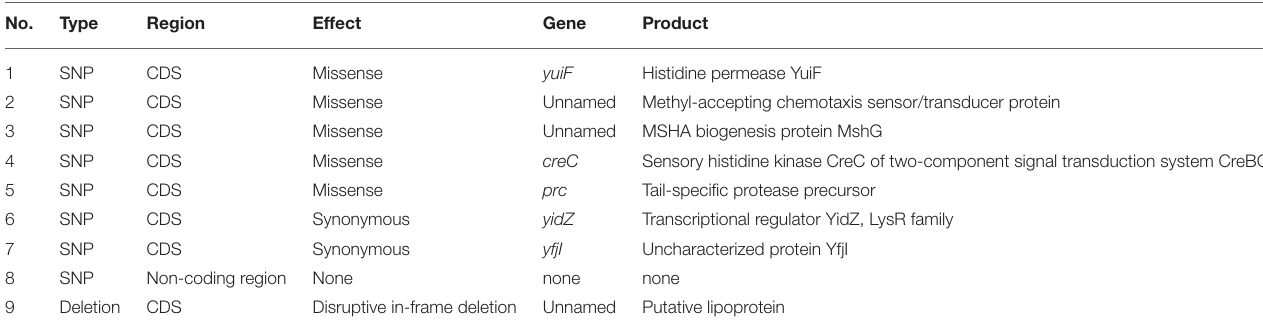
TABLE 2 | Comparative genetic analysis of A. hydrophila Ah2101 and